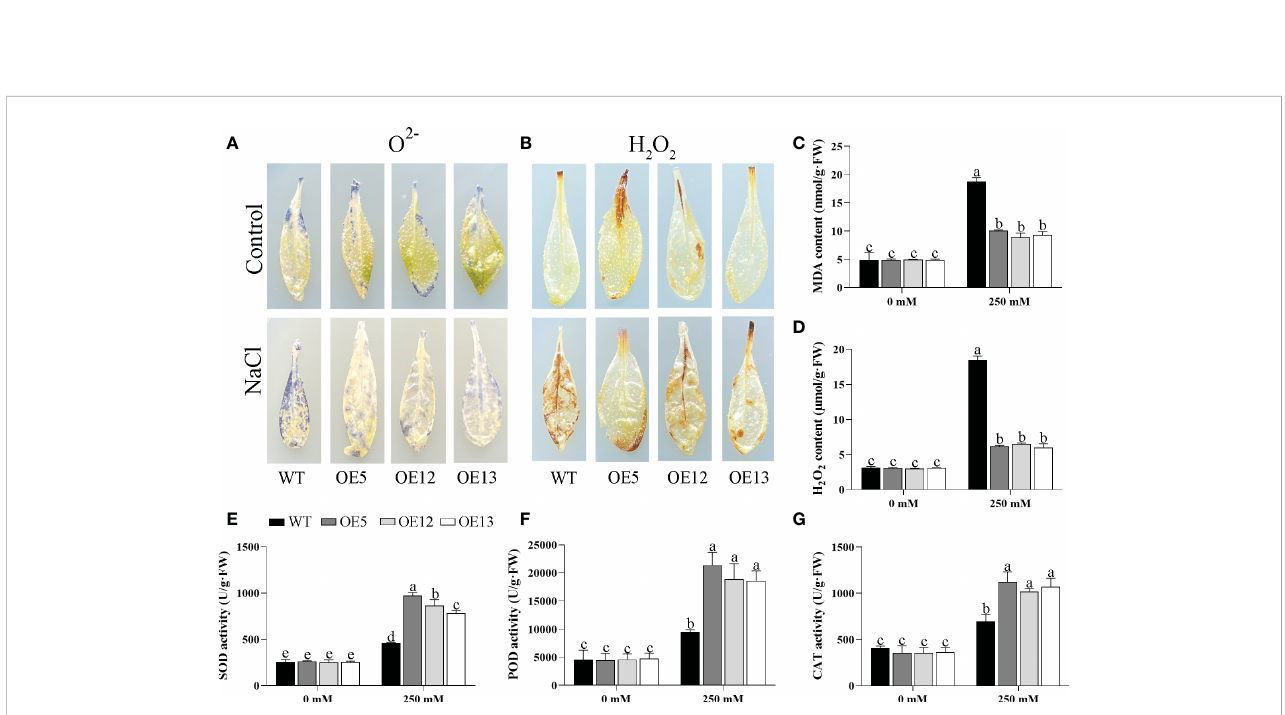
FIGURE 9 Changes in ROS accumulation and antioxidant enzyme activity in CeqHAK6 transgenic lines and WT plants under salt treatment. (A, B) O 2- and H 2 O 2 in the CeqHAK6 transgenic lines and WT plants were detected by DAB and NBT staining. (C, D, E, G) MDA, H 2 O 2 , SOD, POD and CAT content were measured in WT and transgenic plants after salt treatment. All Arabidopsis seedlings were treated with 250 mM NaCl for 10 days. The signi fi cant differences identi fi ed using Duncan ’ s Multiple Range Test ( p <0.05) were denoted by different lowercase letters on the top of bars.